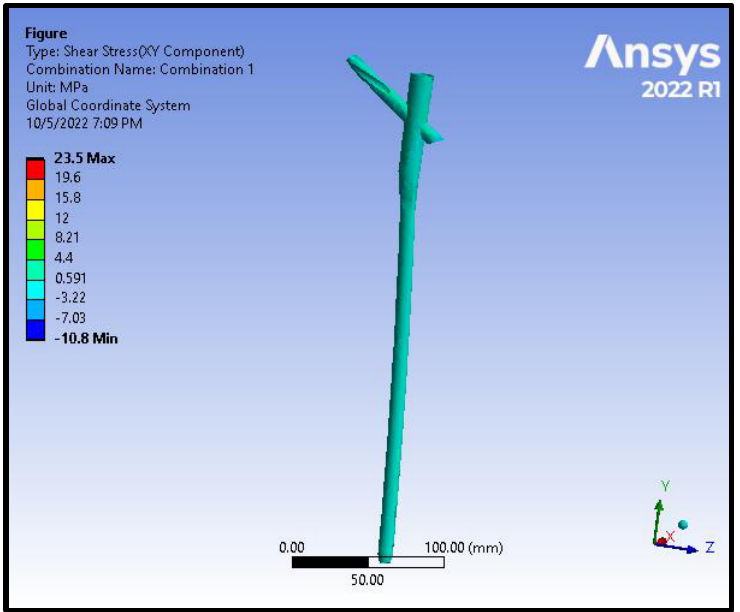
Figure 12. Shear stress distribution on the nail and the helical screw from the model of an intracapsular fracture under axial compression and torsion scenario.